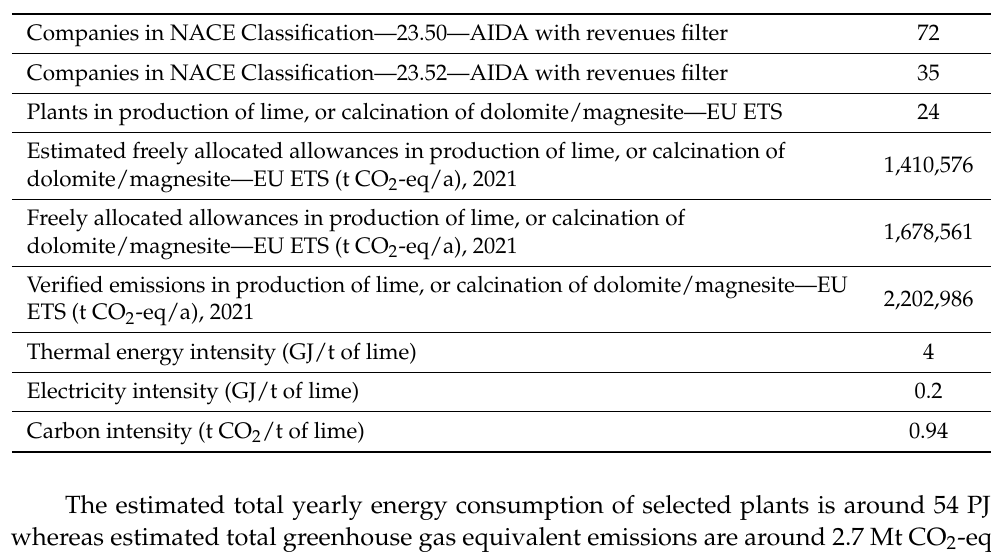
Table 5. Summary data for lime production plants in Italy under EU ETS.